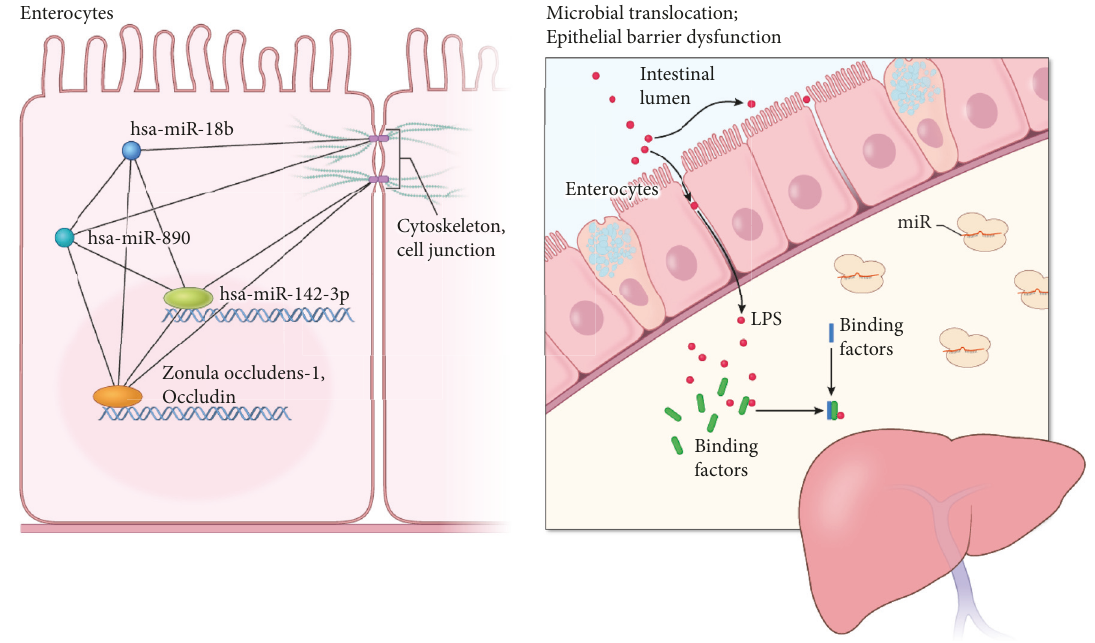
Figure 5: Working model of the MetS-FL miRs in colorectal epithelia. On left, signaling network in which the three miRs participate shows a global cellular miRNome network targeting the epithelial cell junction in colon enterocytes. On right, microbial translocation and epithelial barrier dysfunction are associated with the MetS-FL miR network. LPS: lipopolysaccharides. (Acknowledgment: A. Hoofring, NIH Medical Arts Branch).